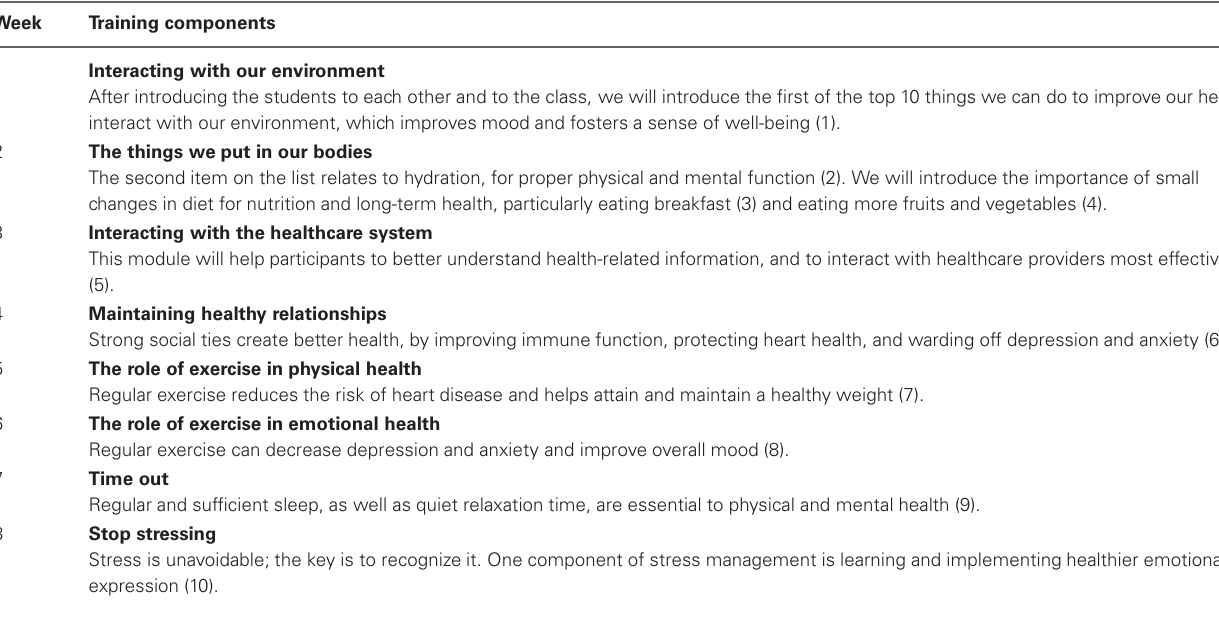
Table 3 | Health discussion control intervention